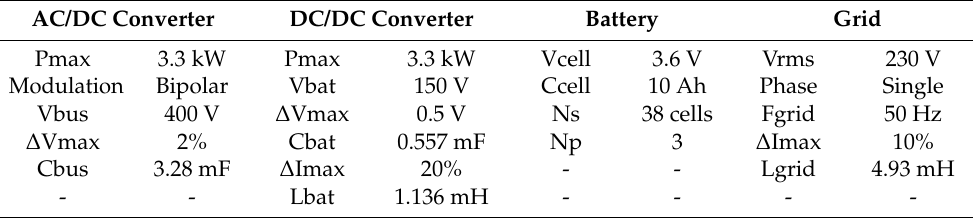
Figure 15. Simulink model of the FB and the Two-Quadrant converter for Light-Duty Vehicles. Table 7. Main characteristics of the Light-Duty system connected to LV Batteries.